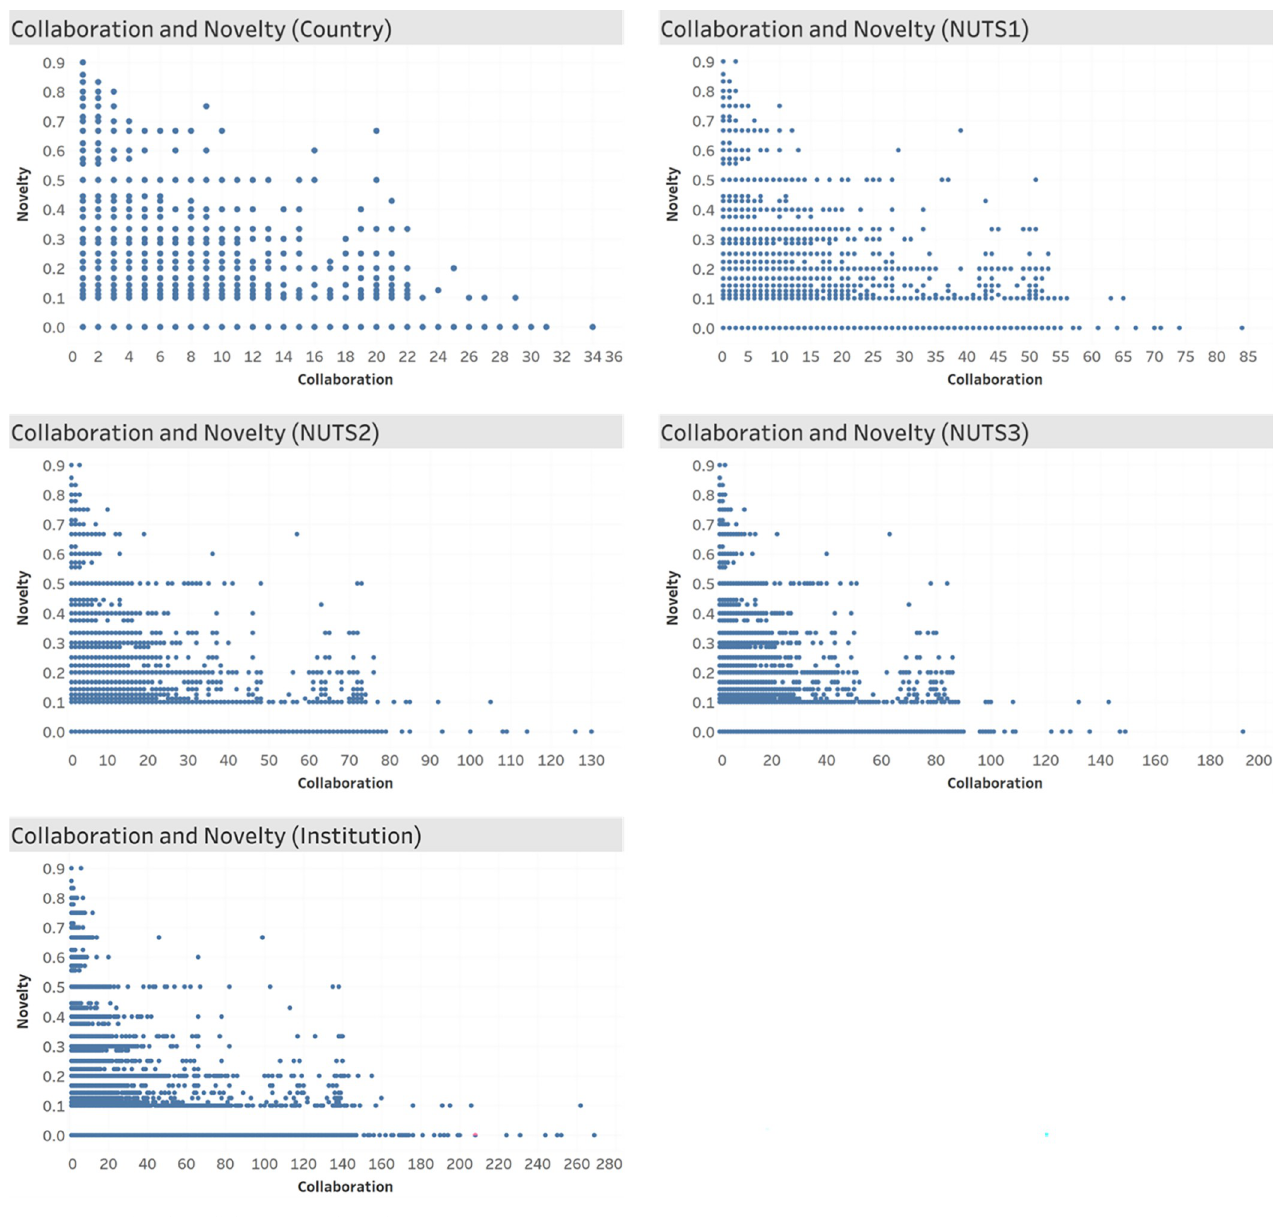
Fig 5. Scatterplots for collaboration and